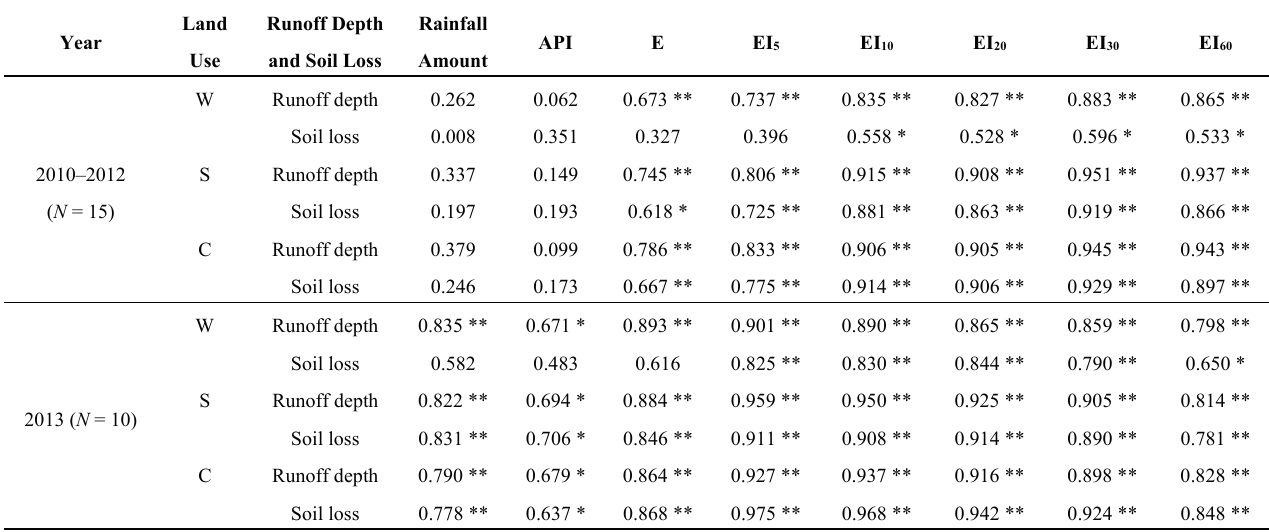
Table 3. Pearson correlation analysis between rainfall parameters and runoff and soil